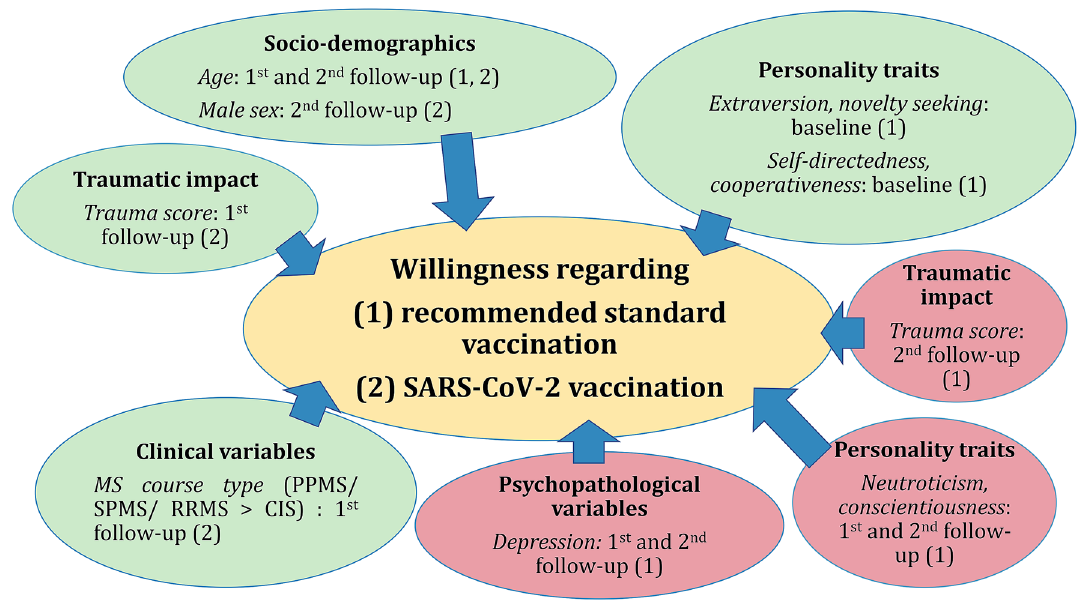
Figure 3. Patient characteristics associated with the willingness regarding recommended standard vaccinations and SARS-CoV-2 vaccinations. The coloured elements show the significant positive (green) or negative (red) associations of socio-demographic, clinical variables, personality traits, psychopathological variables, as well as traumatic impact with the willingness regarding (1) recommended standard vaccinations and (2) SARS-CoV-2 vaccination during the baseline investigation and the two follow-ups. CIS Clinically isolated syndrome, MS Multiple Sclerosis, PPMS Primary progressive MS, RRMS Relapsing remitting MS, SARS-CoV-2 severe acute respiratory syndrome coronavirus 2, SPMS Secondary progressive